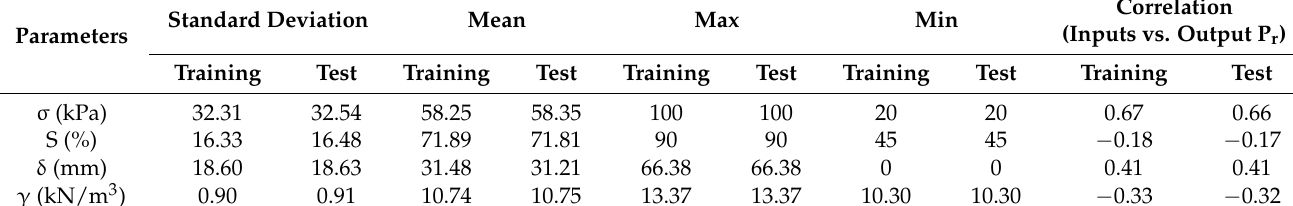
Figure 2. Histogram of normalized pullout resistance values used in the MLA.